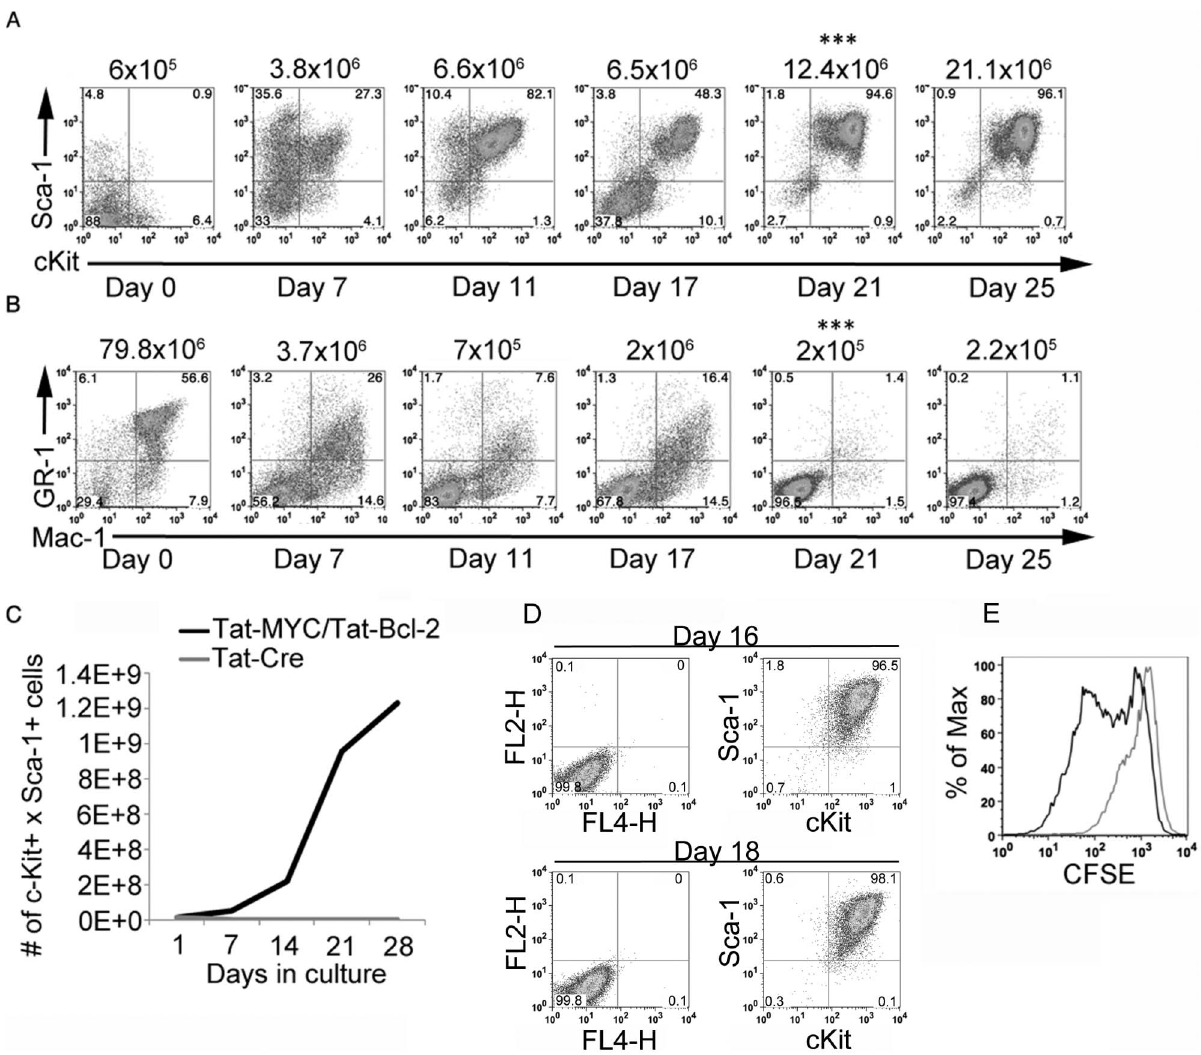
Figure 2. Expansion of murine HSPCs exvivo with Tat-MYC and Tat-Bcl-2. We obtained the bone marrow cells from adult C57BL/6J mice. The bone marrow cells were cultured ex vivo for 25 days in the presence of Tat-MYC and Tat-Bcl-2 or Tat-Cre as a control protein. A. The c-Kit + /Sca-1 + surface phenotype of cells expanded in culture with Tat-MYC and Tat-Bcl-2 is shown. The number of days in expansion culture is shown below the flow panel. The total number c-Kit + /Sca-1 + cells is shown above the flow panel. All cultures were seeded with the heterogeneous bone marrow cell population harvested from C57BL/6J except the panel shown on day 21 with *** shown above the panel. The BM donor mice, shown on day 21, were treated with 5FU 5 days prior to the BM harvest. B. The cells that grew in cultures supplemented with Tat-MYC and Tat-Bcl-2 ( 2A ) were negative for lineage markers Mac-1and Gr-1. C. Kinetics of cell expansion ex vivo cultures with Tat-MYC/Tat-Bcl-2. The culture of murine bone marrow cells expanded with Tat-MYC/Tat-Bcl-2 lead to a 66 fold increase in the number of c-Kit + /Sca-1 + cells in a 28 day period (black trace). By contrast, bone marrow cultured with Tat-Cre did not increase in cell number over the same time period (gray trace). D. CSFE labeled cKit + /Sca-1 + cells expanded in culture with Tat-MYC and Tat-Bcl-2 for 16 days (top row 2 nd panel) and 18 days (bottom row 2 nd panel) compared to the unstained control (both rows 1 st panel). E. The CFSE labeled cells from panel D revealed that cells are undergoing proliferation from day 16 (gray trace) to day 18 (black trace).